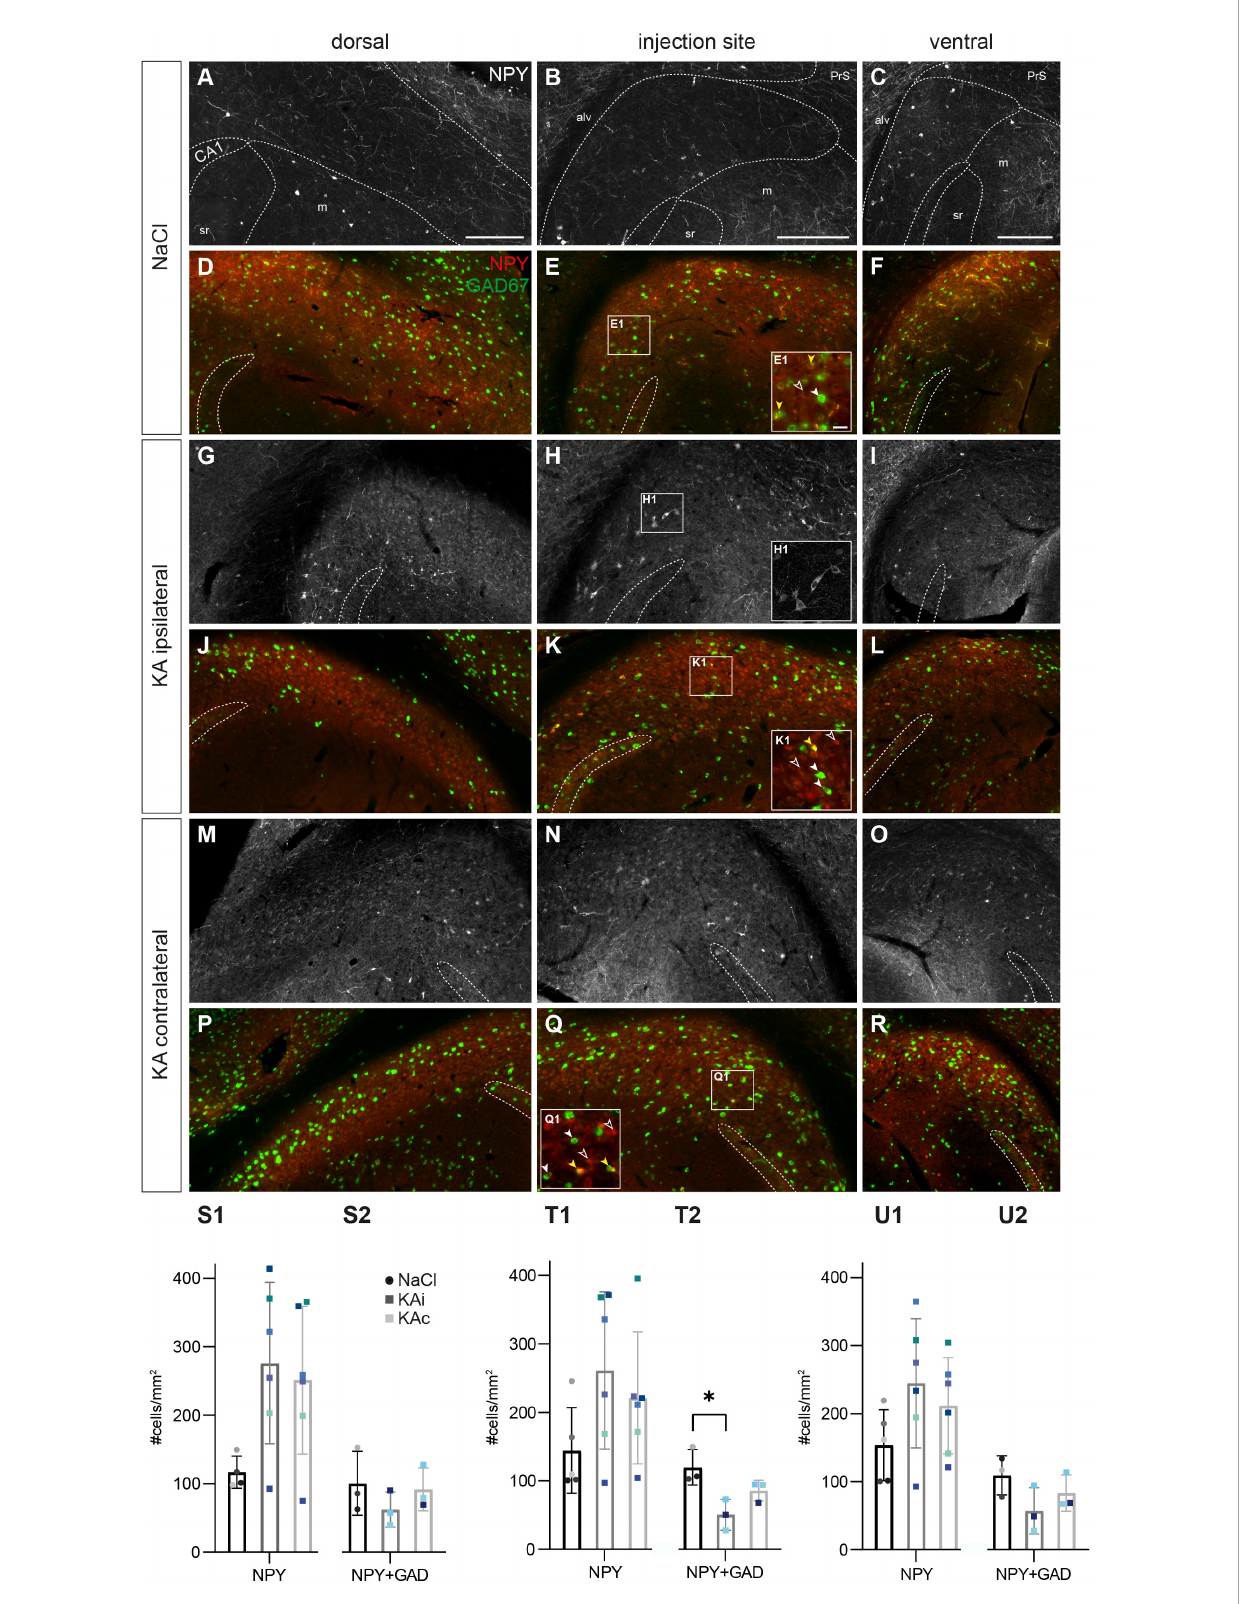
FIGURE5 Kainate (KA) induces an upregulation of neuropeptide Y (NPY), but loss of NPY interneurons. Representative images depicting the subiculum of control (A–F) and KA-injected mice (G–R) . Immunolabeling of NPY + cells [red, (A–C,G–I,M–O) ] and counterstaining for co-expression of Gad67 mRNA using fluorescence in situ hybridization [green, (D–F,J–L,P–R) ]. The localization of the CA1 pyramidal cell layer is indicated. The borders of the subicular pyramidal cell layer toward the alveus (alv) and the molecular layer (m) are delineated as dashed lines according the brain atlas (Franklin and Paxinos, 2008). (A) NaCl-injected control, dorsal subiculum. NPY + cells and their processes are located throughout the pyramidal cell layer